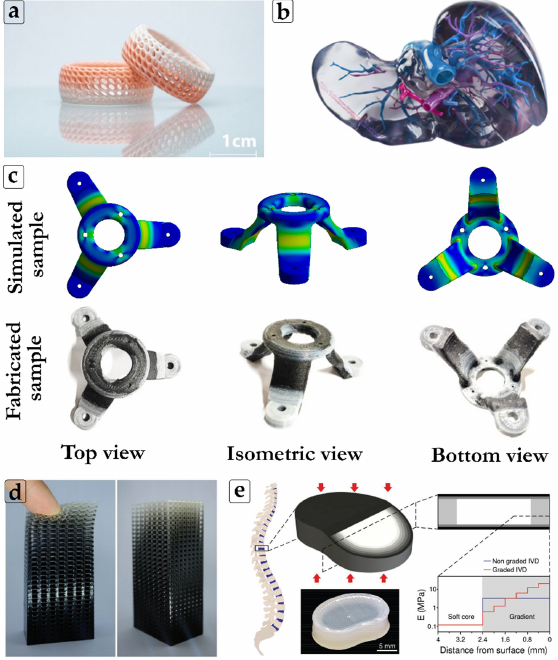
Figure 15. ( a ) Multi-material ceramics 3D printing using CeraFab Multi 2M30 printer, reproduced with permission, photo by Lithoz GmbH, Copyright © 2021 [162], ( b ) 3D-printed medical model for educational purposes [163], ( c ) optimized material distribution of short carbon fiber reinforcements in the ABS matrix; mounting bracket part was fabricated by the FFF technology [101], ( d ) multi-material functionally graded lattice structure produced on the Stratasys J750 with GradCAD Voxel Print, reproduced with permission [164], ( e ) illustration of the loading condition as well as the gradient design of the printed human intervertebral disk. Reproduced with permission, Copyright © 2018 [78].